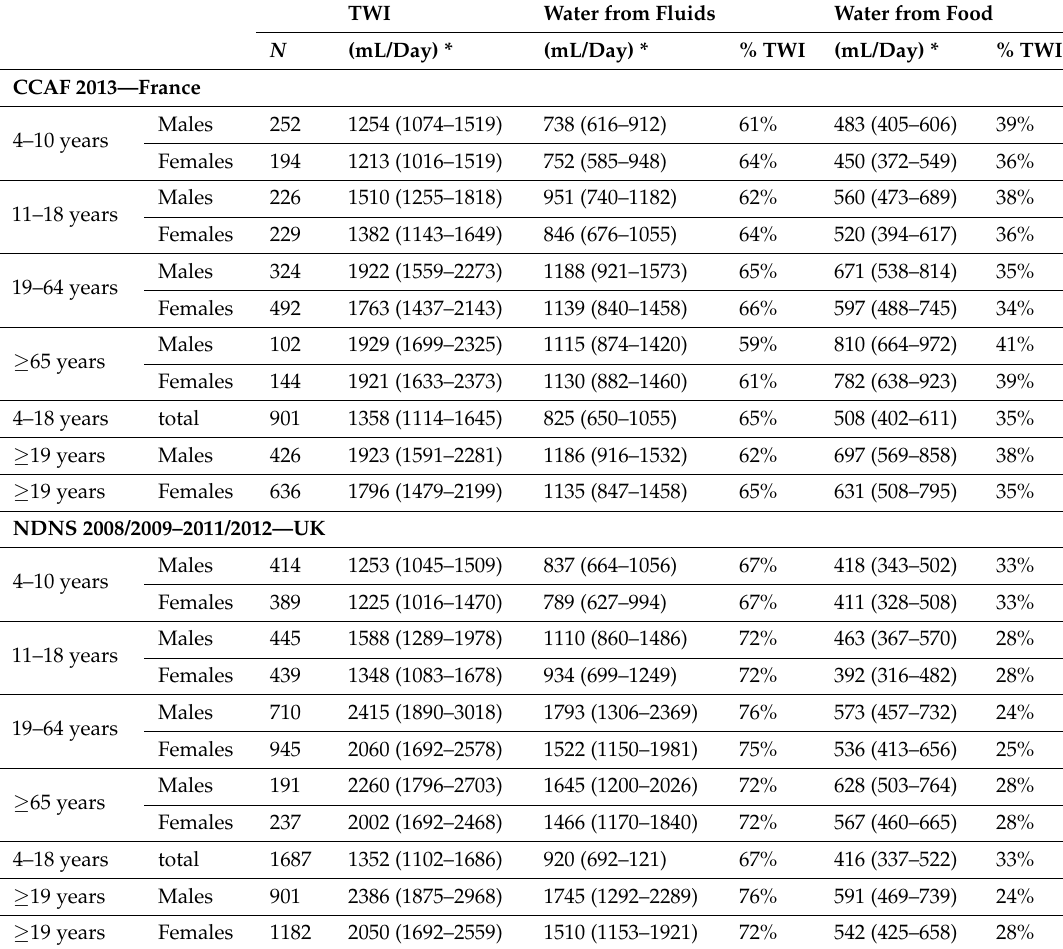
Table 3. Contribution of water from food and fluids to total water intake (TWI) according to country, gender and age